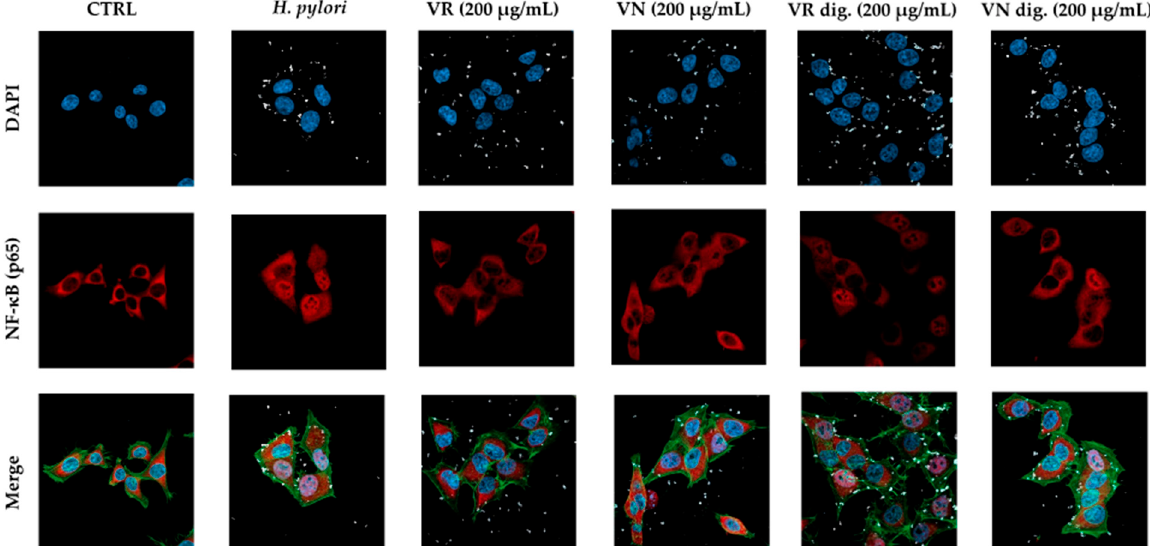
Figure 4. Effect of Castanea sativa Mill. leaf extracts on NF- κ B (p65) nuclear translocation induced by H. pylori . GES-1 cells were treated for 1 h with H. pylori (ratio 50:1, bacteria/cell) in addition to leaf extracts (200 µg/mL) before and after in vitro simulated digestion. NF- κ B (red) nuclear translocation from the cell cytoplasm into the nuclei (blue) was detected by confocal immunofluorescence microscopy (63× objective). Merged images include β -actin (green) and bacterial DNA (CFSE, white) staining. VR, Castanea sativa Mill. var. verdesa leaf extract; VN, Castanea sativa Mill. var. venegon leaf extract; dig., in vitro simulated digestion.